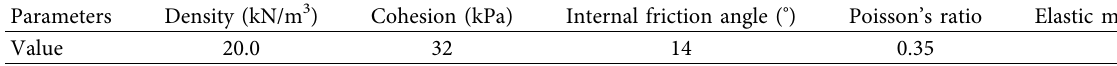
Table 5: Setting table of soil parameters in standard conditions [24].